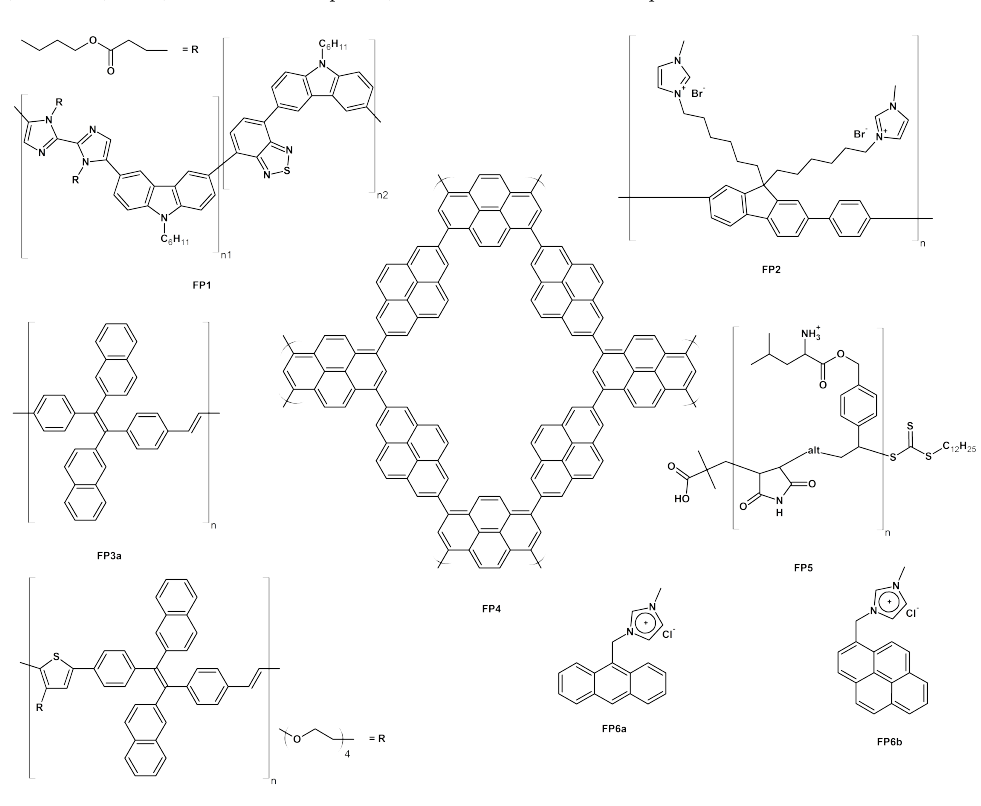
Figure 6. Schematic depiction of selected compounds employed as fluorescent probes for the detection of picric